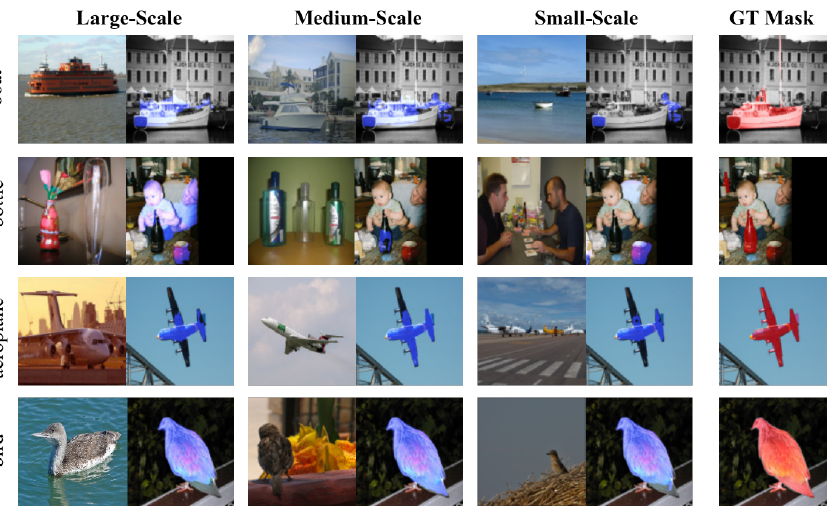
Figure 2. The effect of different support target scales on model prediction. Compared to the poor performance of larger target scale gaps, pairs of images with consistent scales are able to make better predictions. For each pair, the left side is the support image, and the right side is the prediction